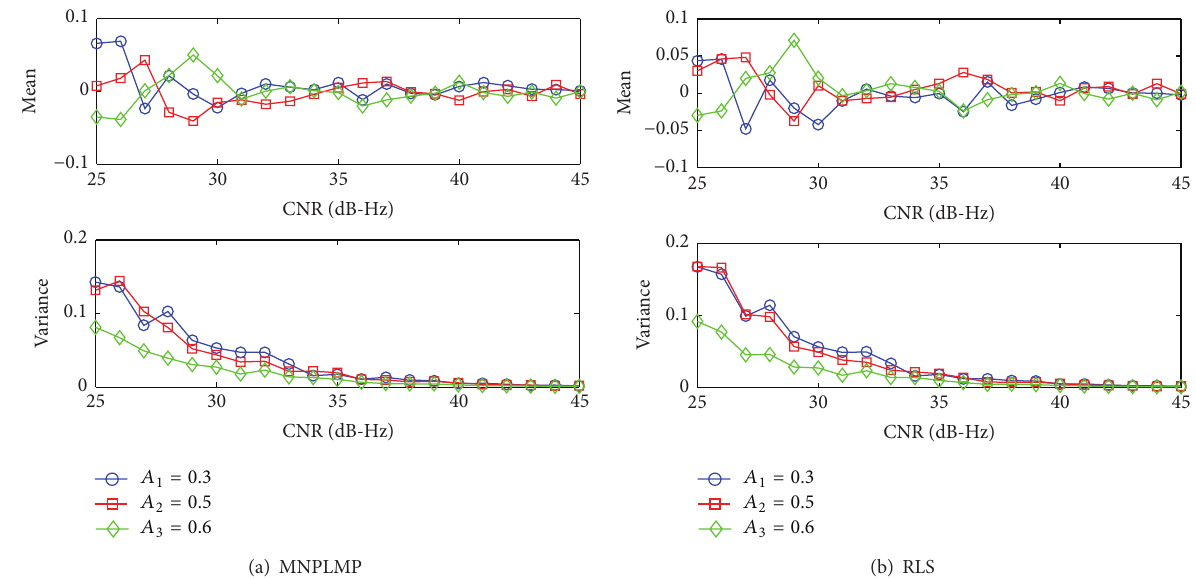
Figure 12: Multipath amplitude estimation errors in various CNRs under the AWGN environment.